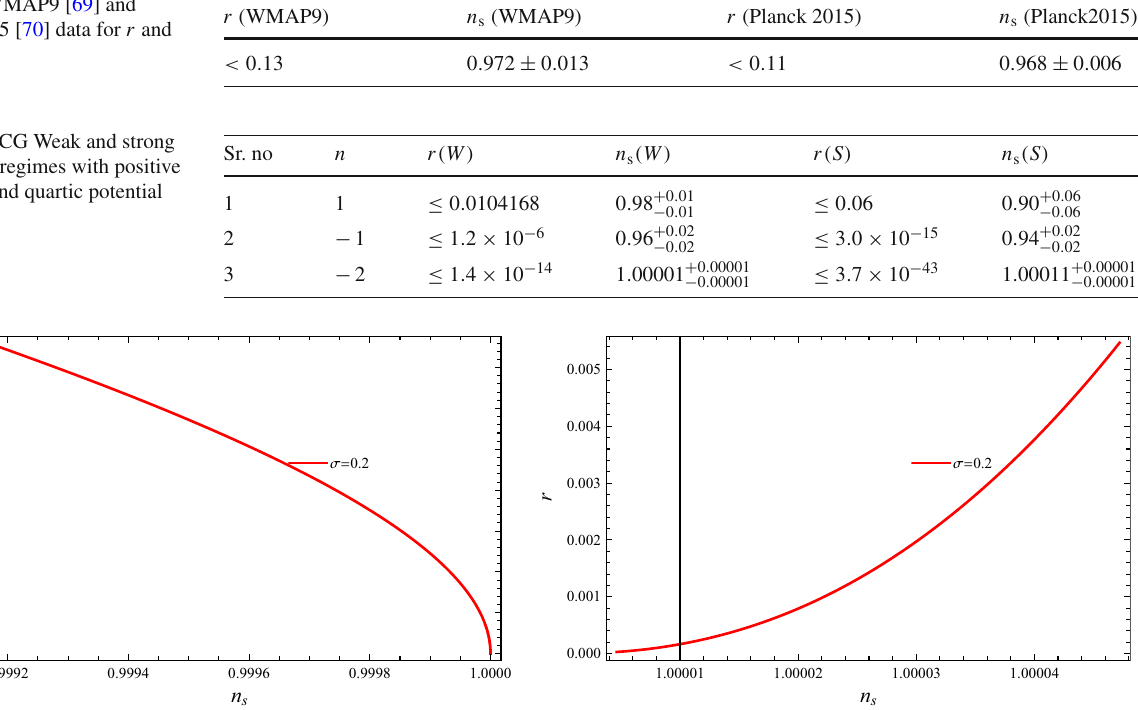
Table 1 WMAP9 [69] and